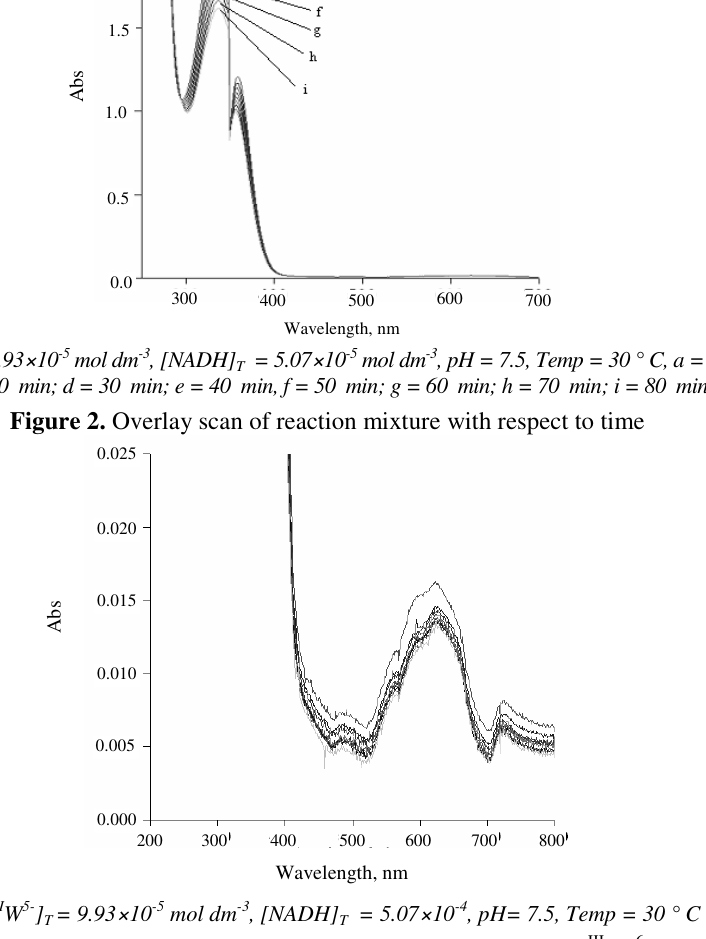
Figure 3 . Scan of reaction mixture with respect to time showing [Co III W] 6-